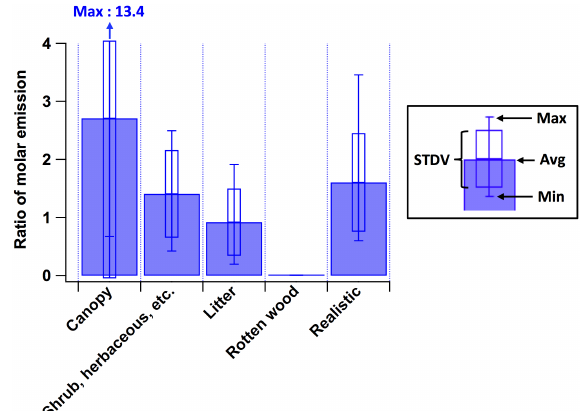
Figure 10. Ratios of fire-integrated molar emissions of total VOCs from high- to low-temperature pyrolysis (“ P VOC High- T / P VOC Low- T ”) for different type fuel parts, obtained using PMF results of 15 different